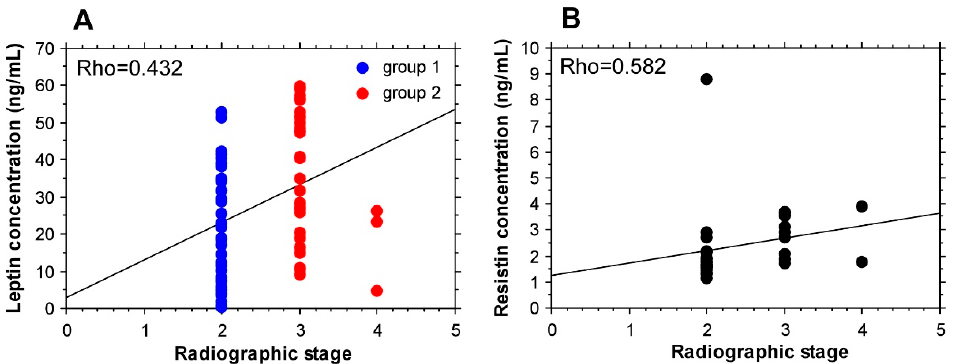
Figure 3. Radiographic stage correlations. ( A ) An association with leptin serum levels (group 1—2nd radiographic stage, group 2—3rd and 4th radiographic stage). ( B ) A correlation with resistin serum levels in patients with BMI < 30 kg/m 2 .